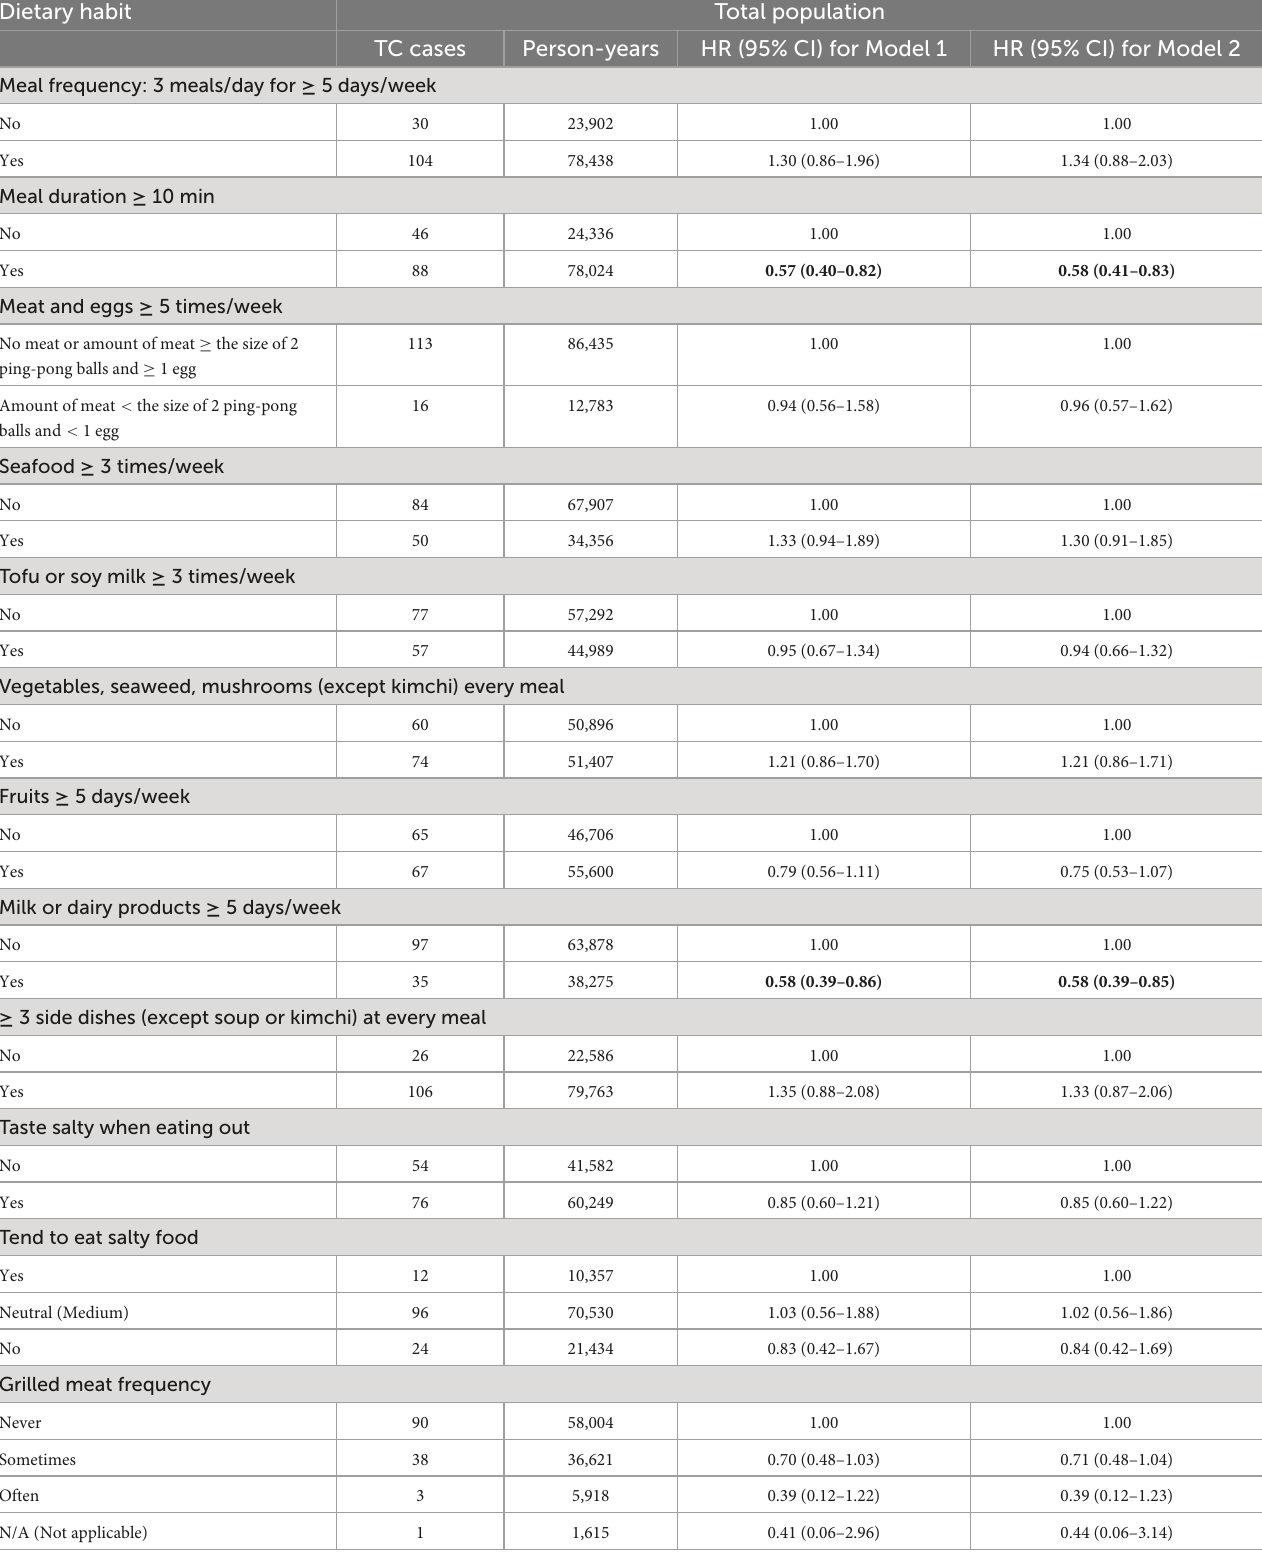
TABLE 2 Hazard ratios (HRs) and 95% confidence intervals (CIs) of incident thyroid cancer (TC) related to dietary habits in total population. Dietary habit Total